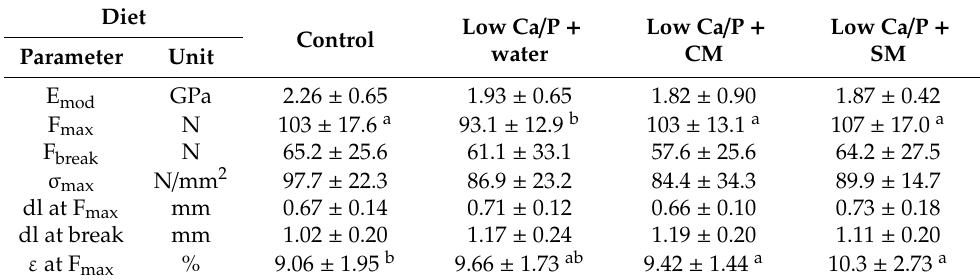
Table 4. Mechanical characteristics of femora from rats fed di ff erent milk diets.